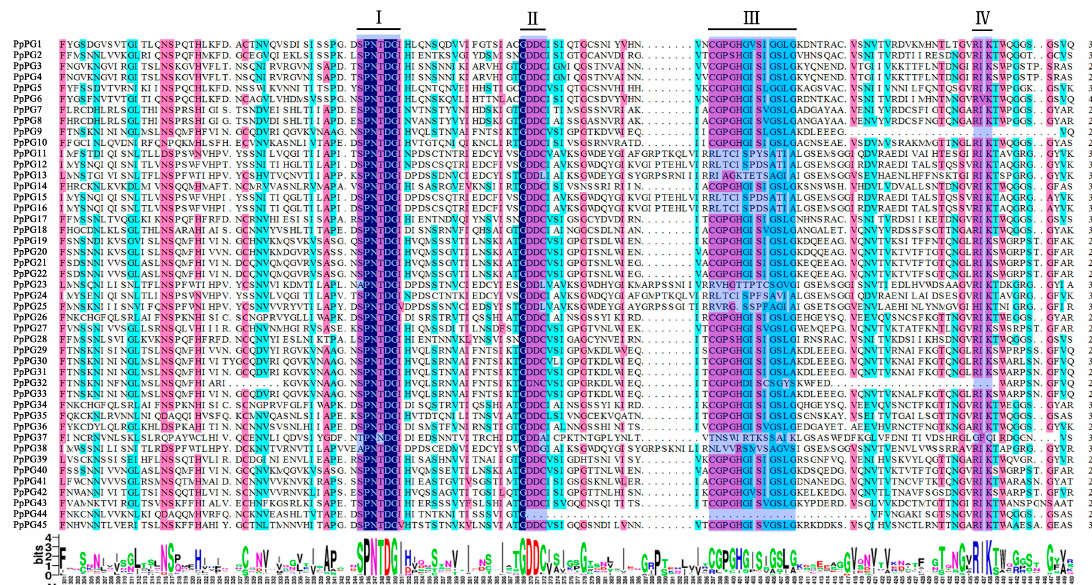
Figure 1. Multiple sequence alignment of peptides of peach PGs. Blue shading and underlining indicates four typical conserved domains of PGs, referred to as domains I, II, III and IV. The consensus sequence is shown by letter logos. Different colors indicate different similarities (black: 100%, Magenta: ≥ 75%, cyan: ≥ 50%).